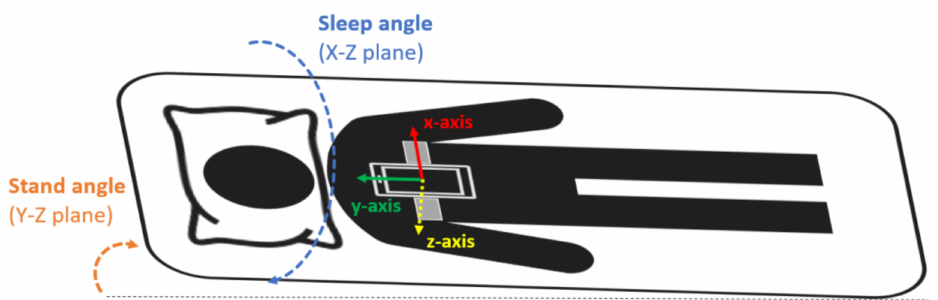
Figure 1. Smartphone placement attached to the subject’s thorax with an elastic band. The orientation of the smartphone accelerometer’s axes and the sleep and stand angles are also